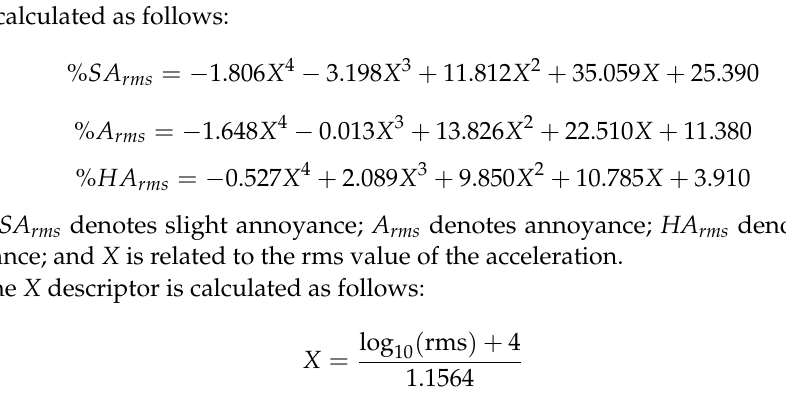
Table 8. Vibration annoyance rate of the third-floor test room during peak hours of train opera- tion. Single Peak Hour